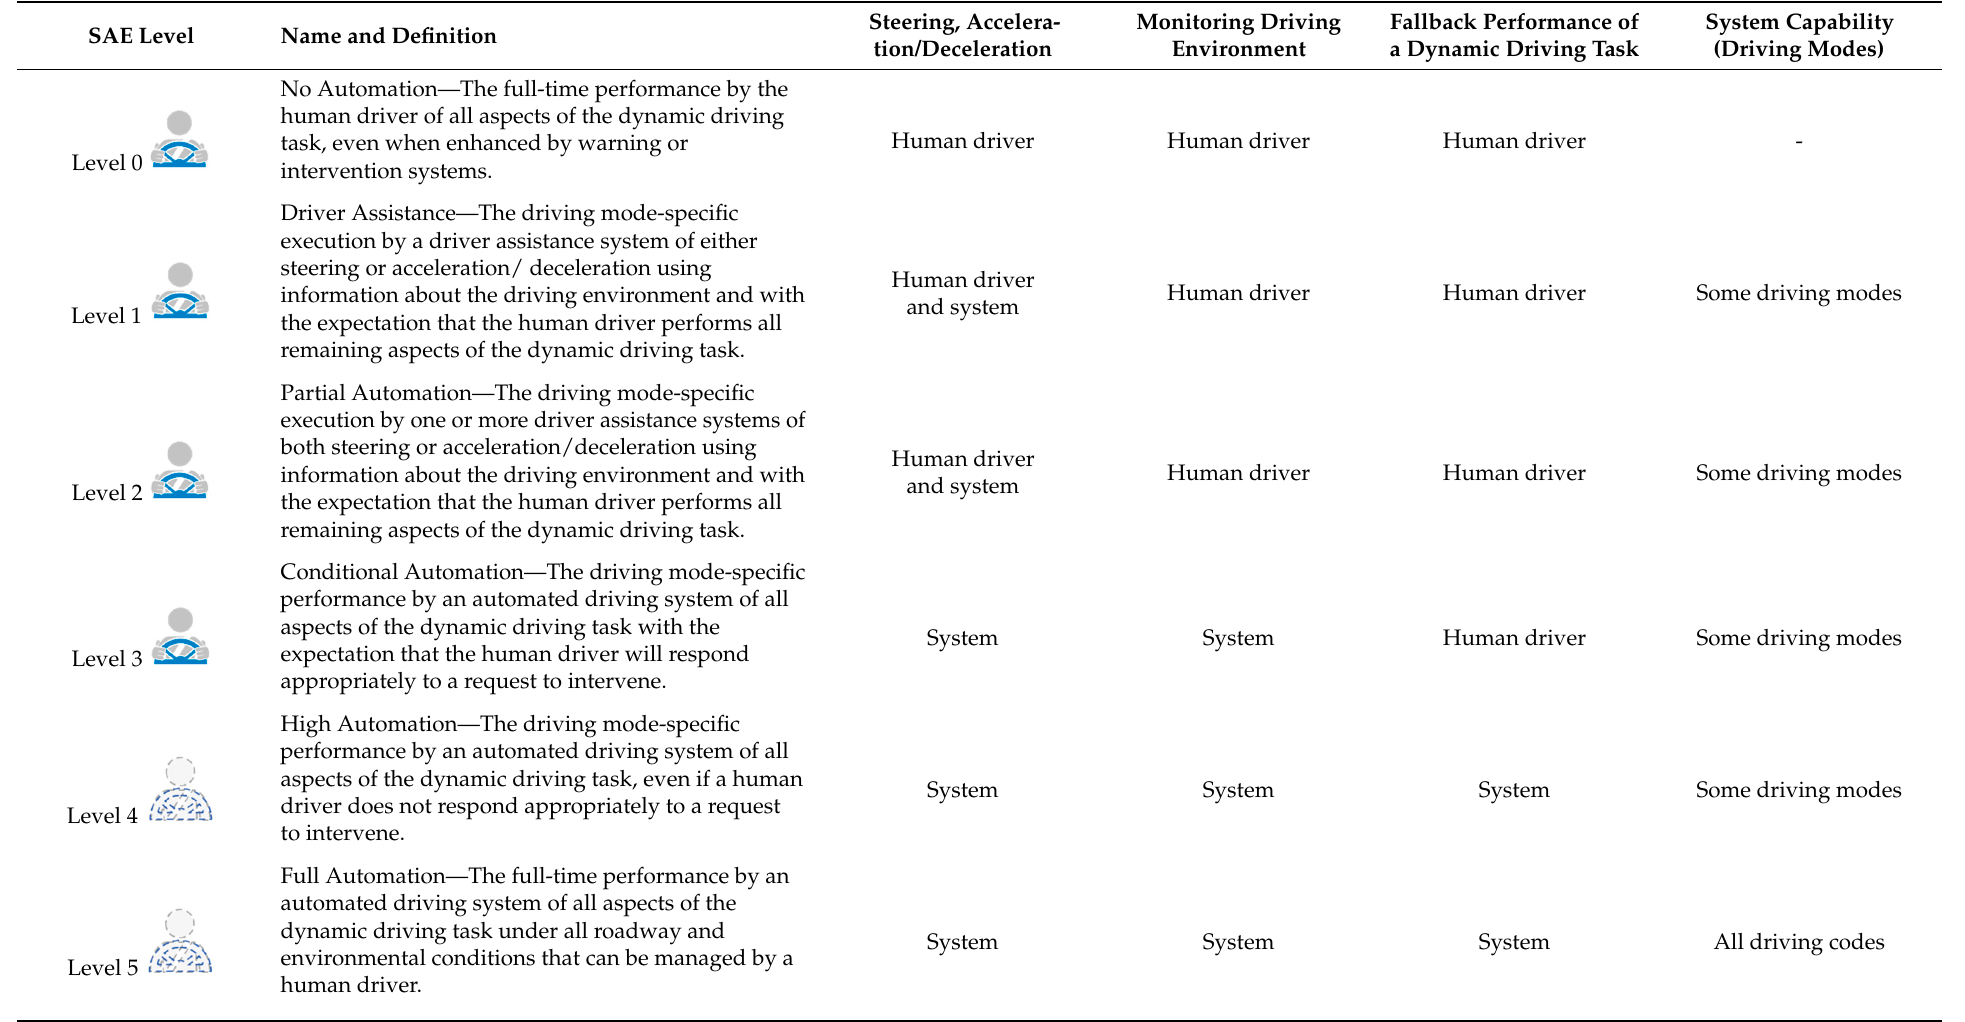
Table 3. SAE vehicle automation levels